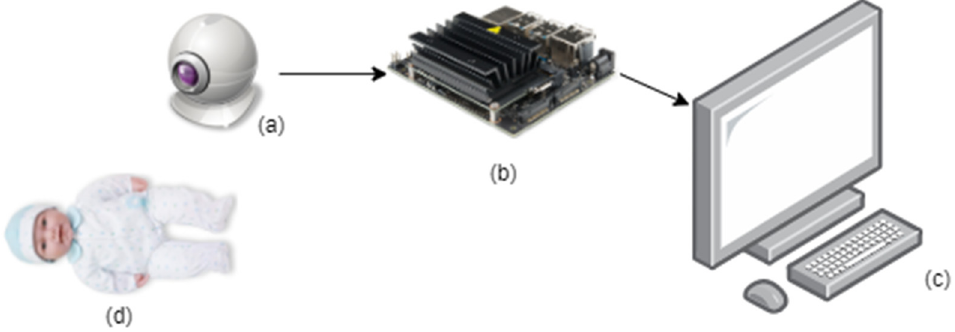
Figure 3. Experimental setup: a night-vision camera ( a ) is interfaced with an NVIDIA Jetson Nano microcontroller ( b ). Monitor, wireless keyboard, and wireless mouse ( c ) were connected with the Jenson Nano. Realistic baby doll ( d ) of both genders and different races were put under the camera during experiments.